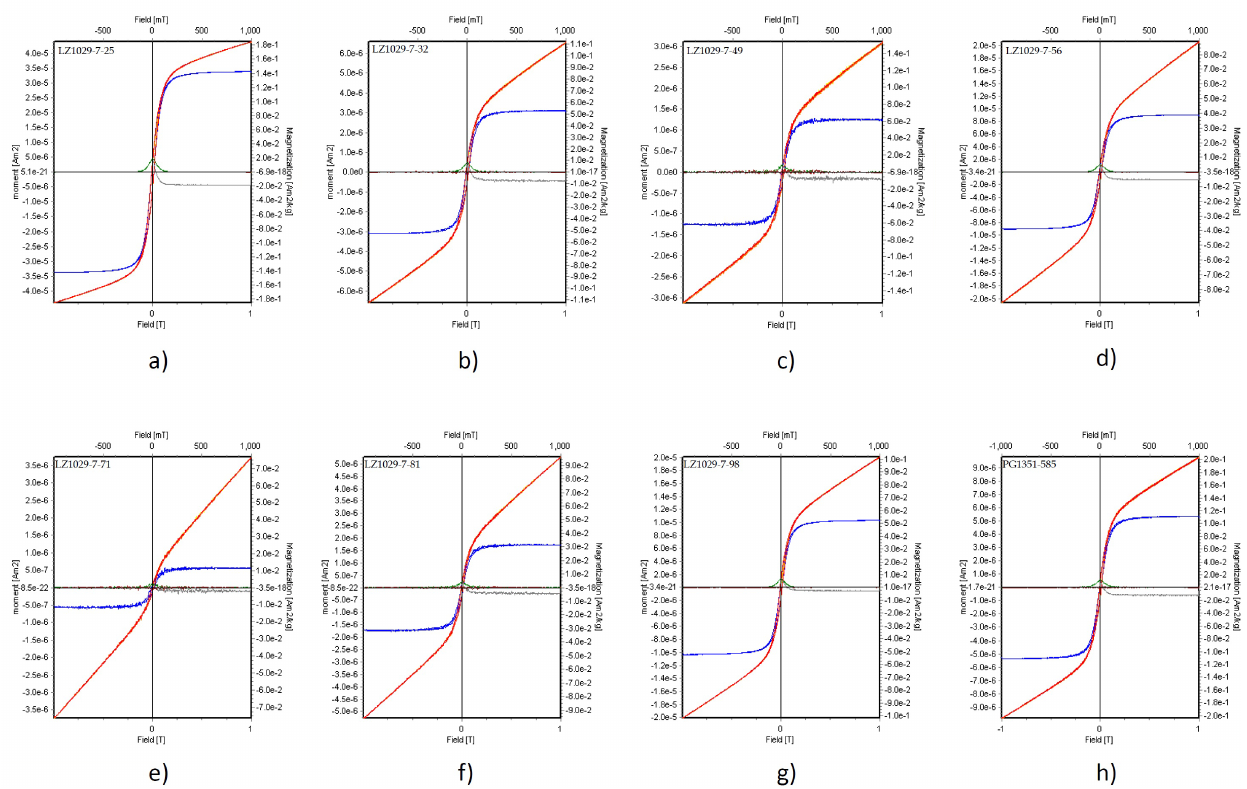
Fig. 7. Selected examples of hysteresis loops from high susceptibility areas ( a , b , g , h ), transitional ( c , d , f ) and low susceptibility areas ( e ) in LZ1029. Loops have been corrected for paramagnetic